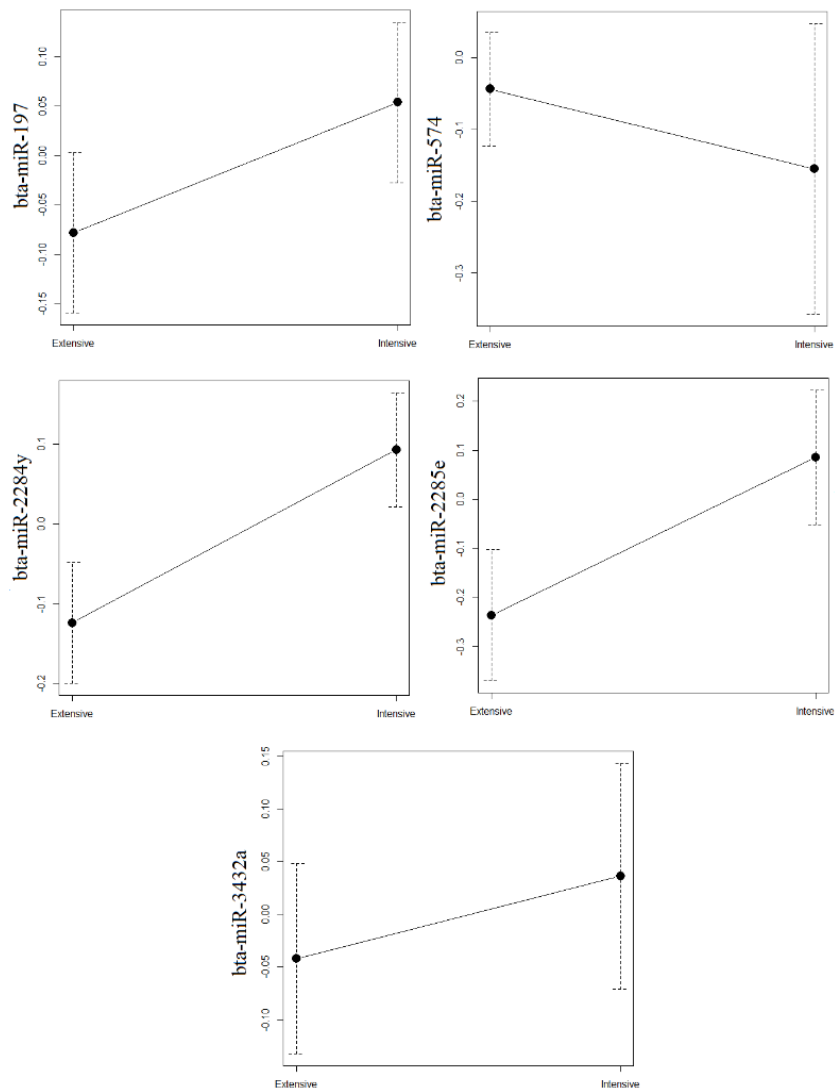
Figure 2. Average levels of miRNAs estimated by qRT-PCR in cellular fractions of milk from extensive and intensive farms. On the X axis, production systems are represented; on the Y axis, average levels of each miRNA are represented. The errors bars indicate standard deviation.